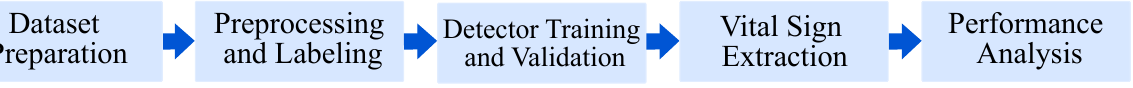
Figure 2. Overview of the